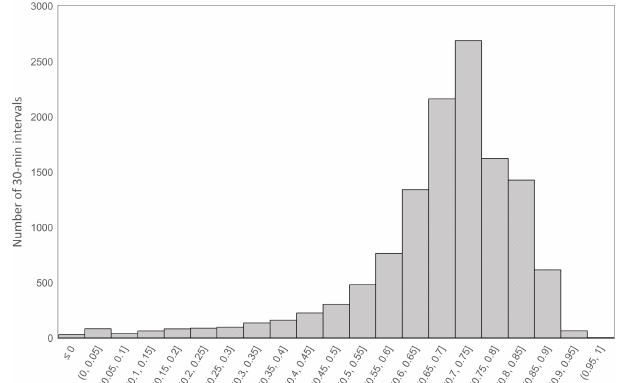
Figure 3. Histogram of the flux footprint contributions of beech forest to the EC measurements at DK-Sor during the observation period from 1 April to 31 December 2018. Note that this dataset comprises all valid 30min intervals, while the energy balance clo- sure correction method is only applied for those with z i /L < 0.